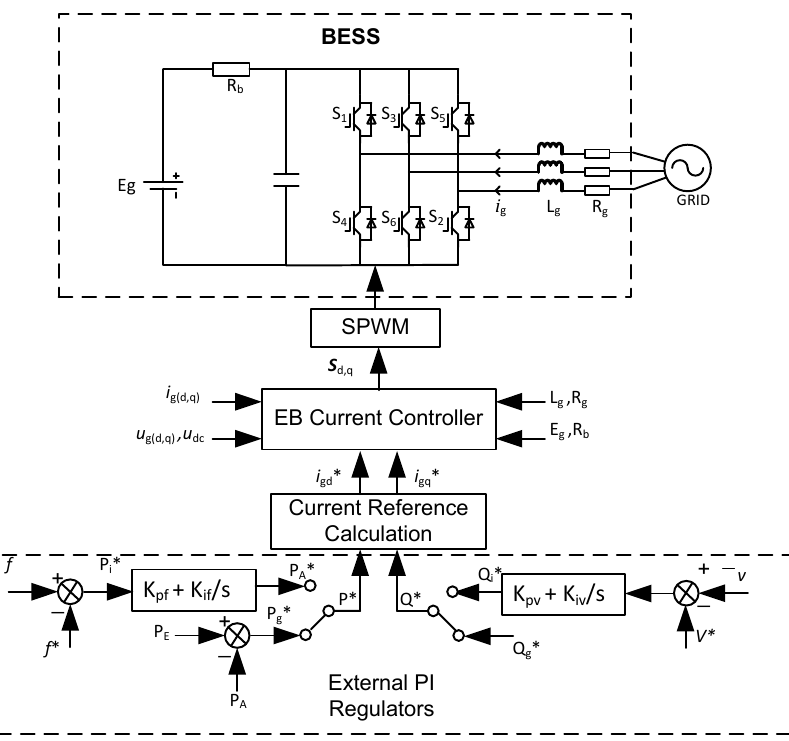
Figure 14. The topology of energy-based (EB) BESS control strategy.